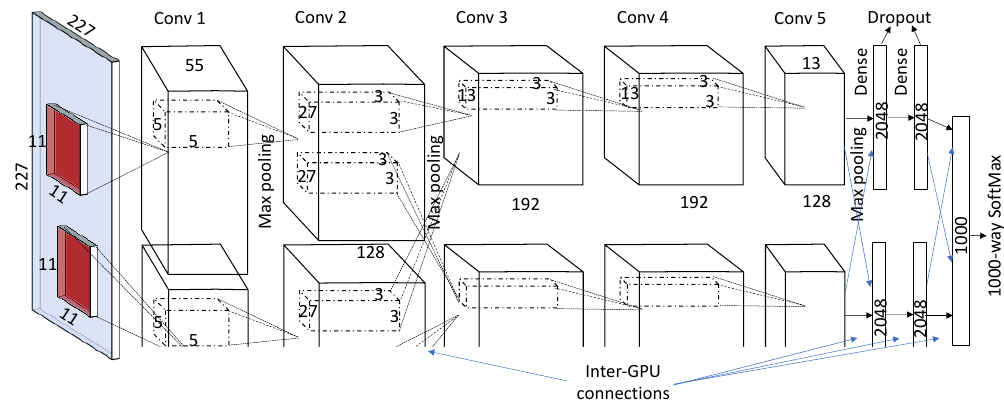
Figure 4. A typical architecture of AlexNet [14].